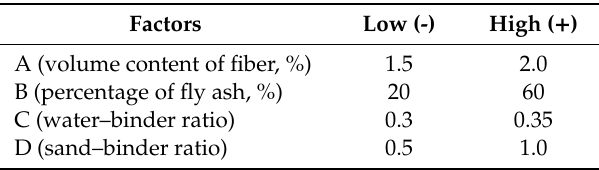
Table 3. The levels of factorial design.